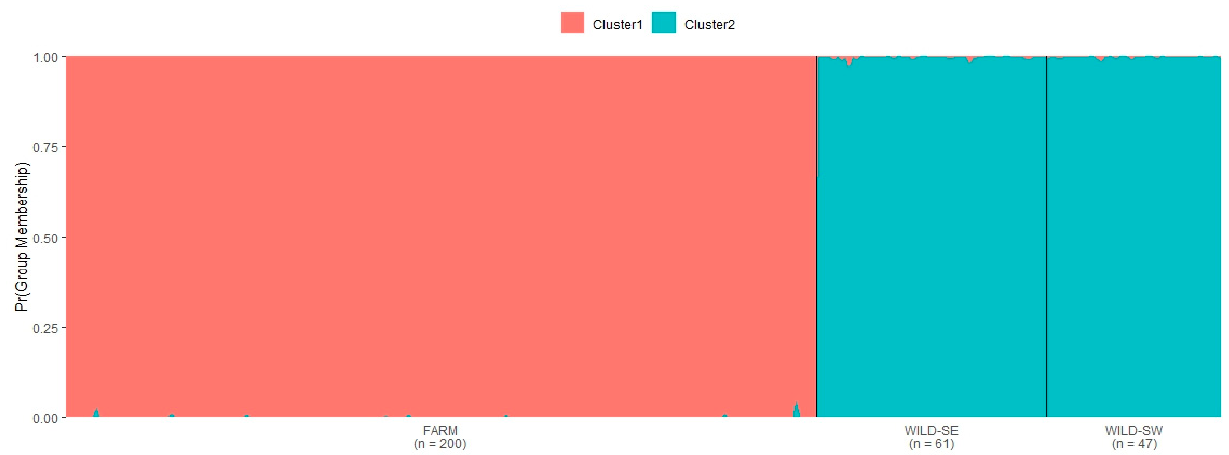
Figure 2. Bar plot showing probability of assignment for individual wild and farm red foxes at the most highly supported value of genetic clusters (K = 2).